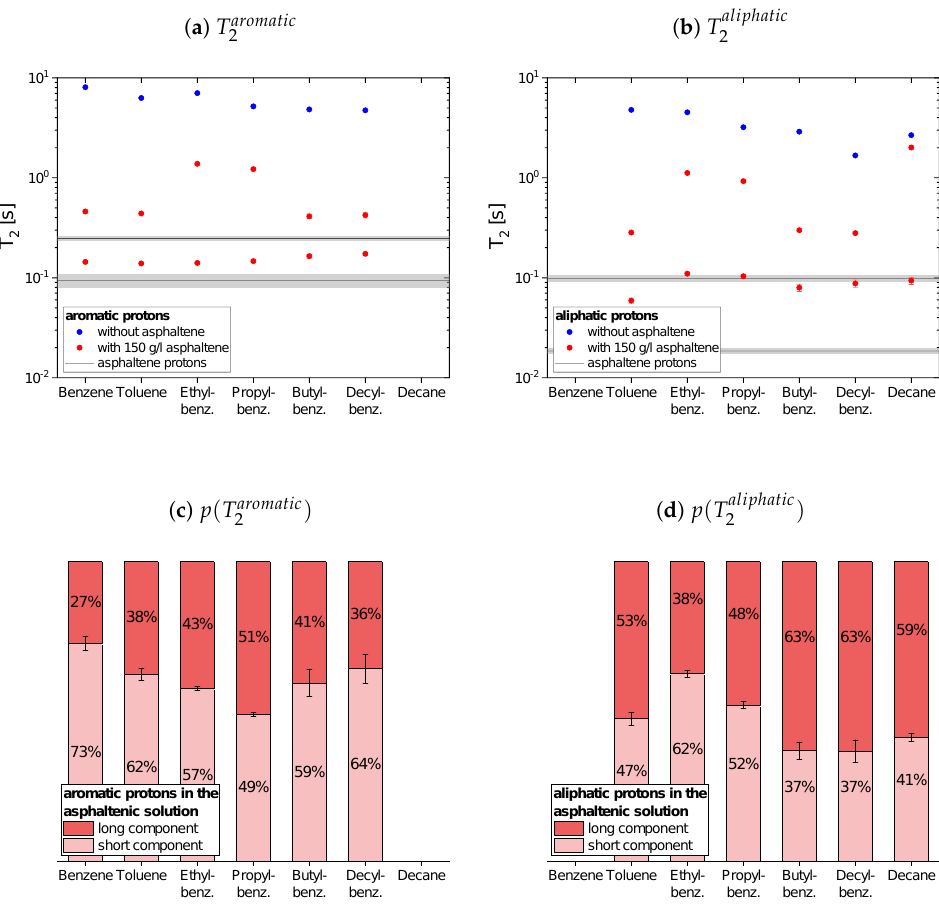
Figure 8. Top: Transverse relaxation time constants T 2 of the aromatic ( a ) and aliphatic ( b ) protons in the asphaltene-free and the asphaltenic solution. The black lines indicate the T 2 constants of the asphaltene protons in a benzene-d 6 solution. Bottom: Relative weight of the T 2 components of the aromatic ( c ) and aliphatic ( d ) protons in the asphaltenic solution. The x-axis distinguishes the different solutions, consisting of 5vol% of the specified maltene and 95vol% benzene-d 6 without or with 150g/L